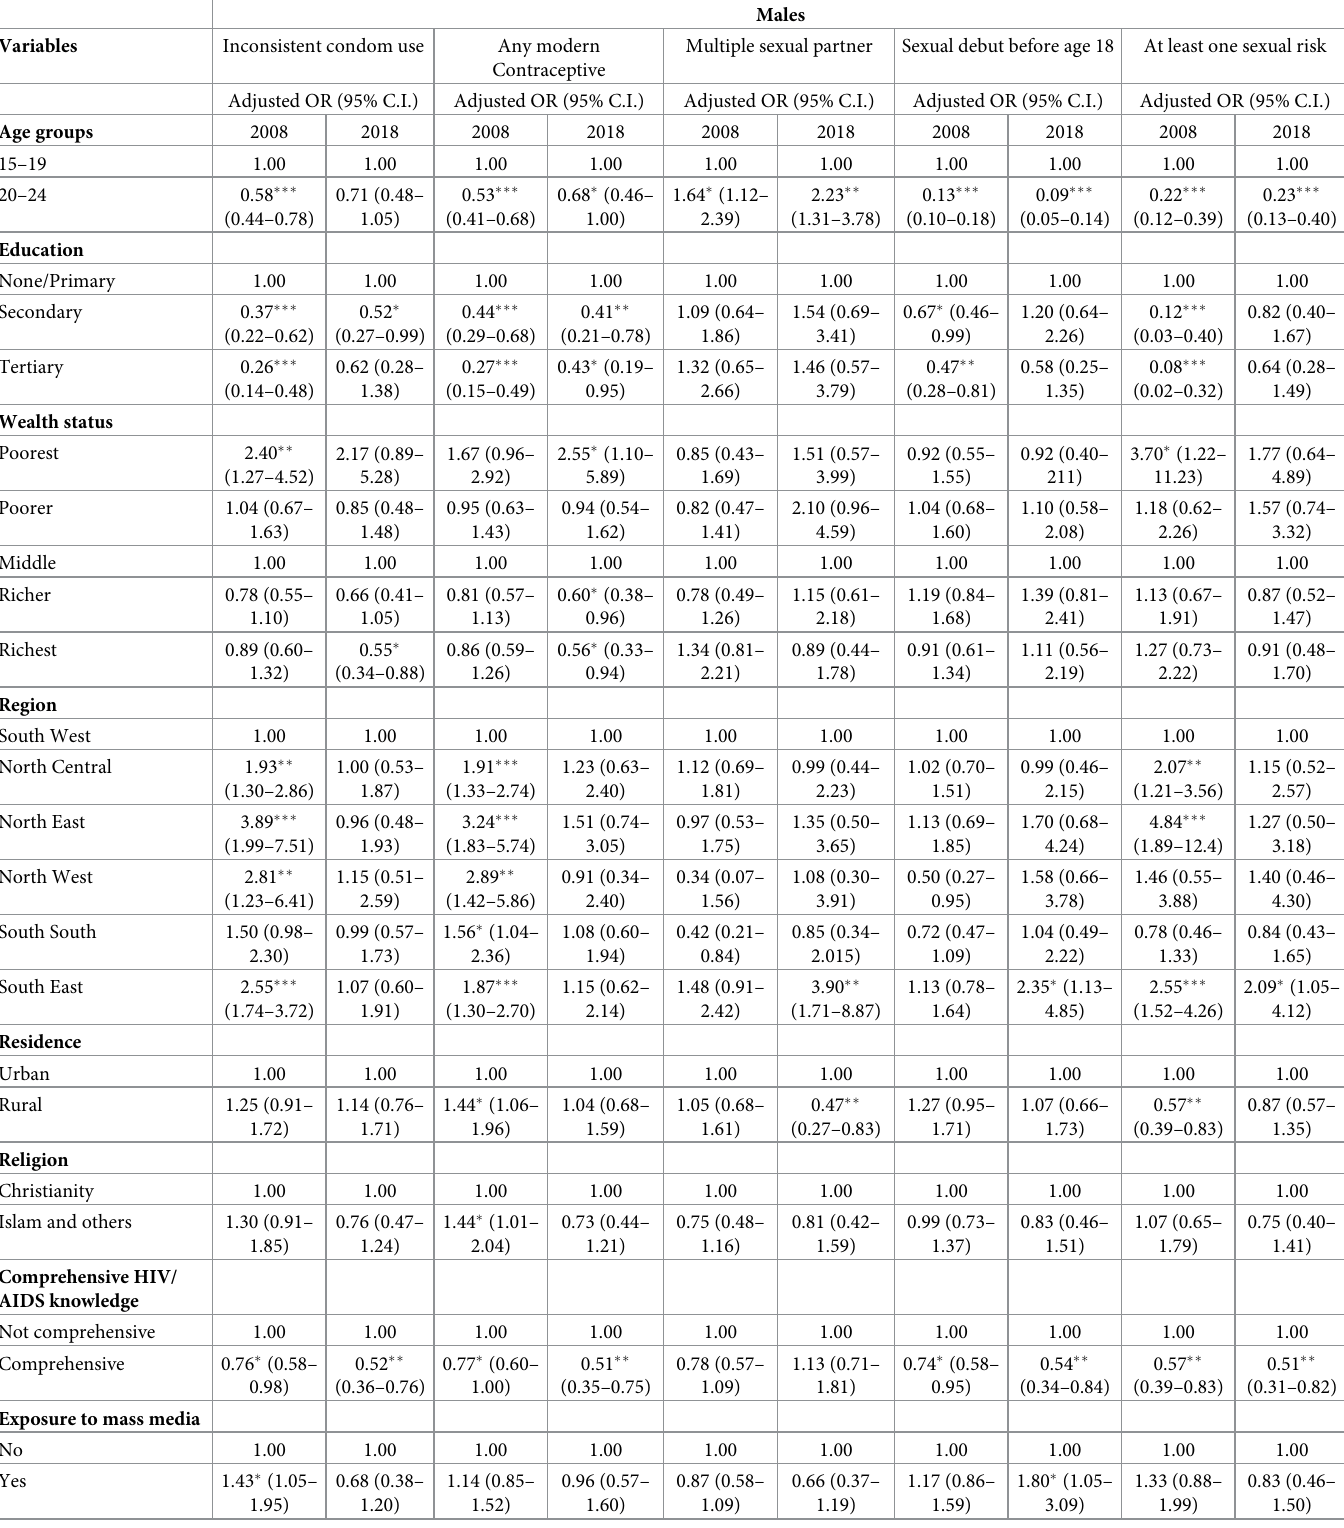
Table 5. Binary logistic regression showing factors associated with sexual behaviour among young people.